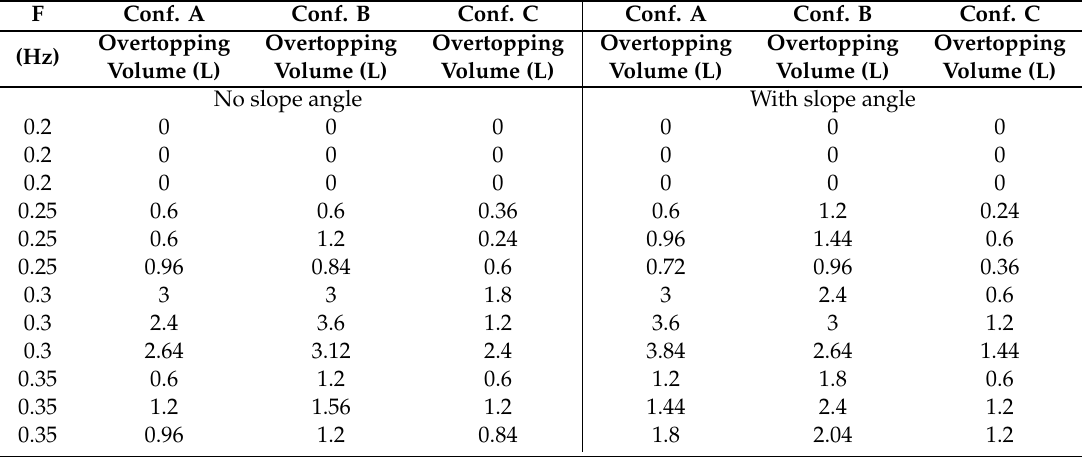
Figure7. Sinewavehydraulicconditions; relationshipbetweenwavecrestamplitudeAandovertopping volume Q (averaged results); slope angle adopted within the experimental facility. Table 4. Experimental testing parameters collected for sine wave (F = frequency) with and without slope